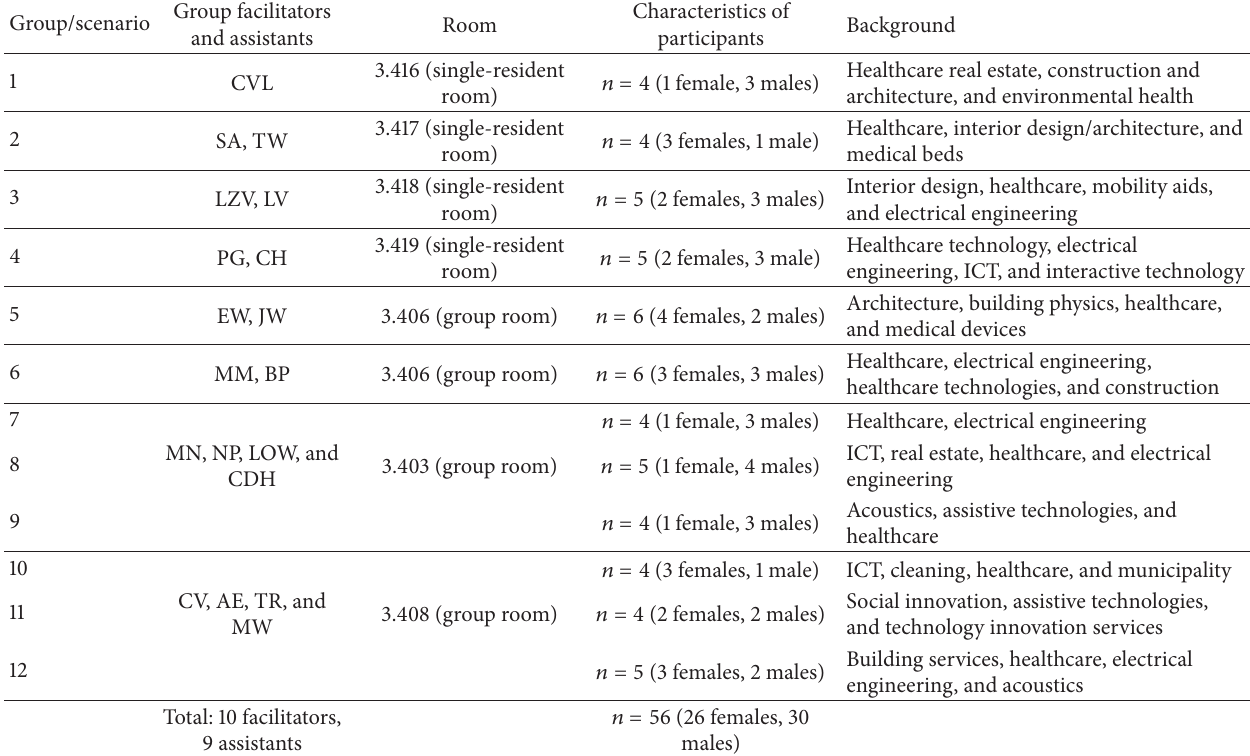
Table 1: List of sessions and the characteristics of the